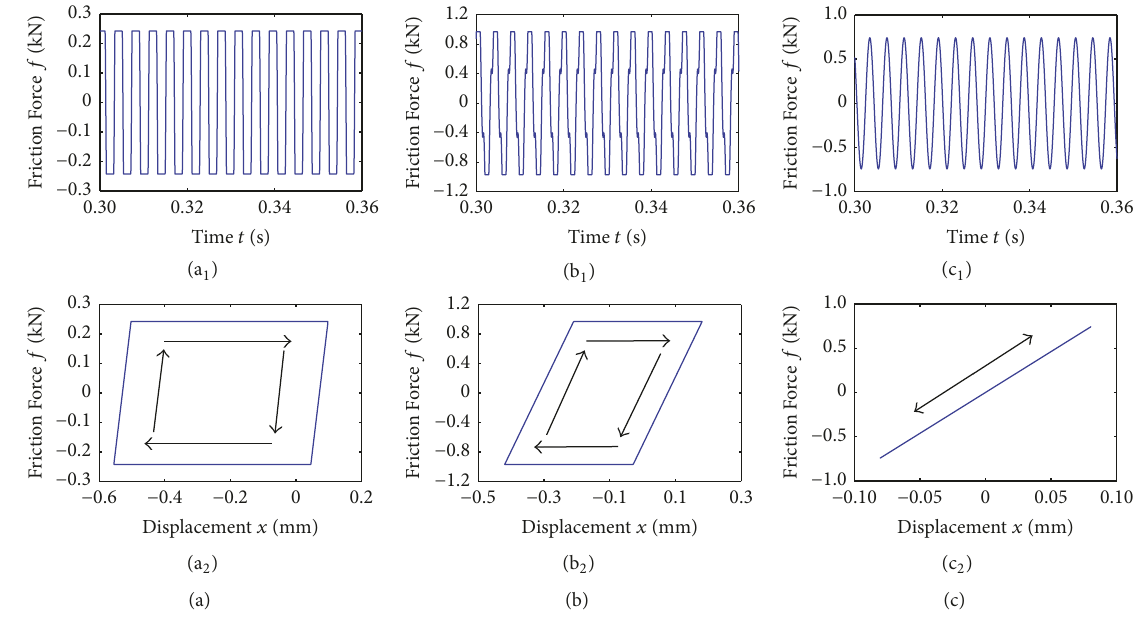
Figure 5: The variation curves of dry friction force at different rotating speeds (subscript 1 represents the variation curve of dry friction force and subscript 2 represents the hysteresis